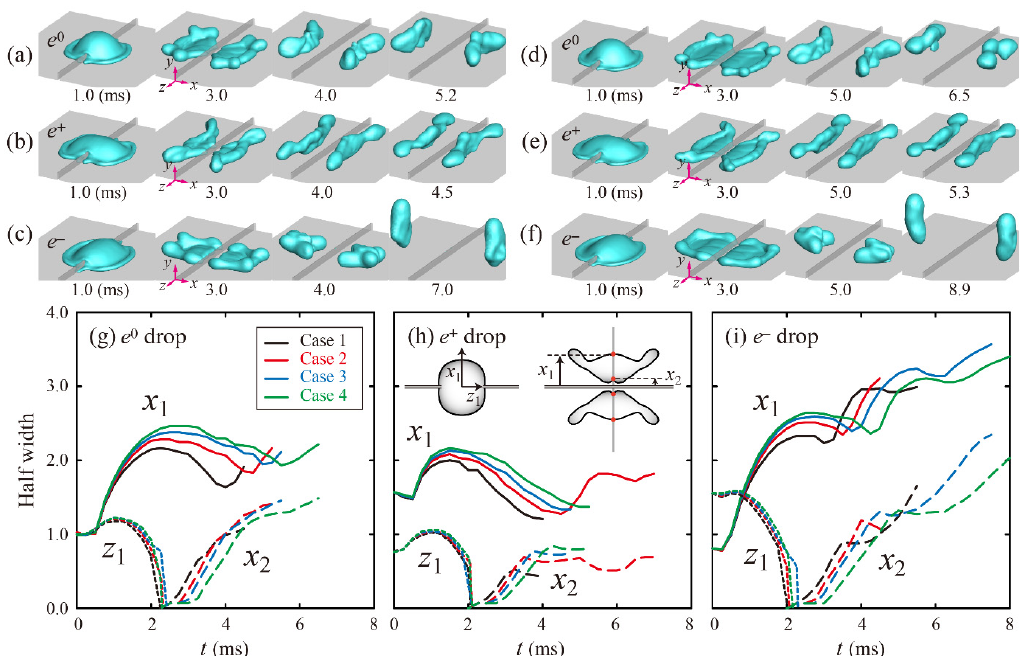
Figure 3. Snapshots of ethanol aqueous solutions of ( a – c ) 5 wt.% (Case 2) and ( d – f ) 20 wt.% (Case 4) at U = 1.3 m/s. The last snapshot for each e is captured at the moment of bouncing of drops from the surface and ridge. ( g – i ) Temporal variations in dimensionless half widths of e 0 , e + , and e − drops for Cases 1–4 until drops rebound from the surface and ridge. Solid, long dashed, and short dashed lines represent x 1 , x 2 , and z 1 , depicted in the inset of ( h ), respectively.